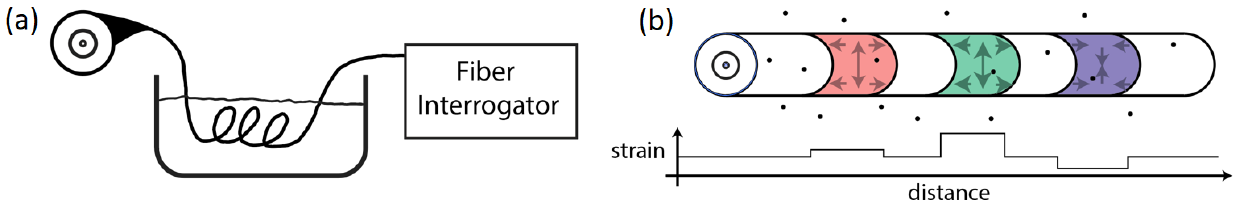
Figure 1. ( a ) Principle of swelling-based chemical sensing: an optical fiber with a polymeric coating is immersed in an analyte and a fiber interrogator is used to monitor the strain transduced to the silica core. ( b ) A fiber can contain segments with different coating materials which all can be read out simultaneously using distributed sensing. Exposure to an analyte (illustrated by the black dots) leads to different swelling of the distinct coating materials (red, green, purple) such that a “fingerprint” strain signature of the analyte can be recorded simultaneously.